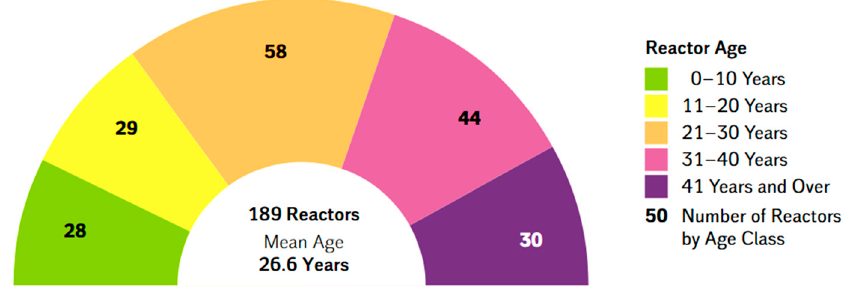
Figure 1. The overall age of the world’s nuclear reactors divided by the number of reactors currently operating (July 2020) [6].